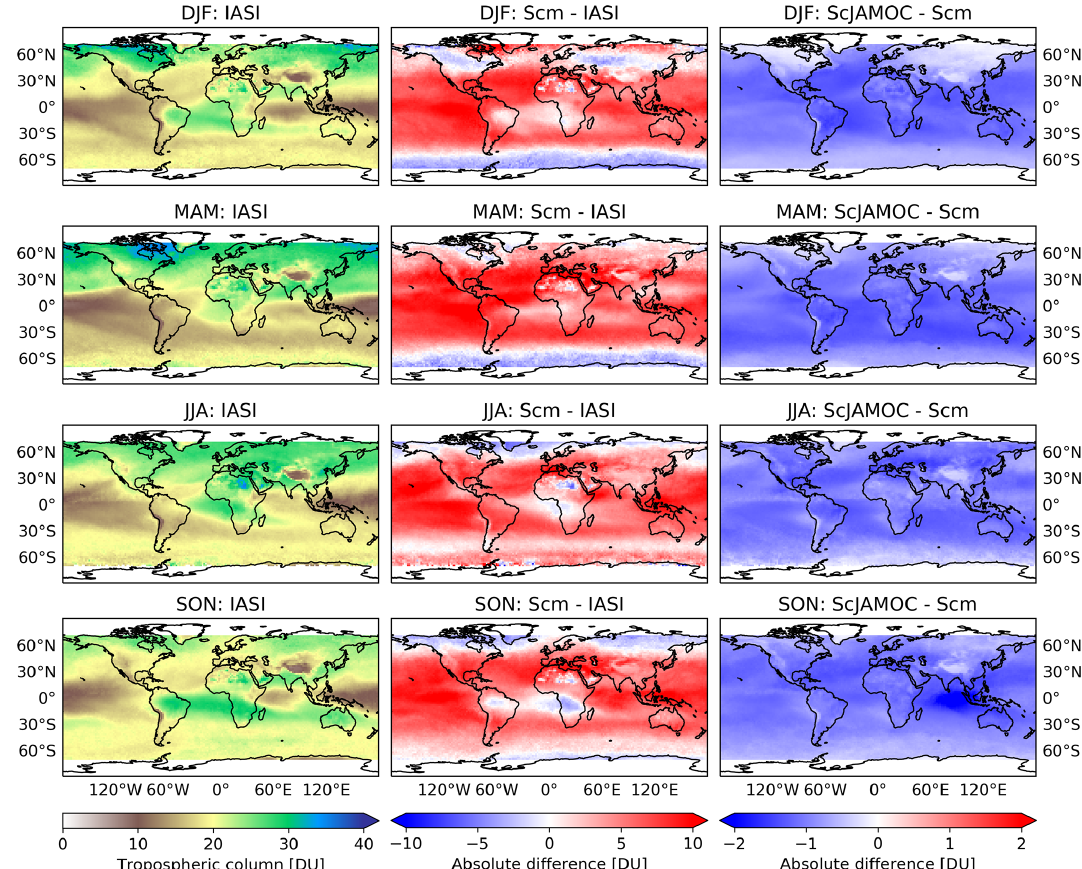
Figure 11. Seasonal (December–February, DJF; March–May, MAM; June–August, JJA; September–November, SON) tropospheric O 3 col- umn comparison between IASI-FORLI satellite observations and EMAC: IASI-FORLI satellite observations (left), Scm simulation in com- parison to IASI-FORLI observations (centre), and ScJAMOC in comparison to Scm (right). The characteristics of each simulation are provided in Table 1. For this comparison, the tropopause is defined at